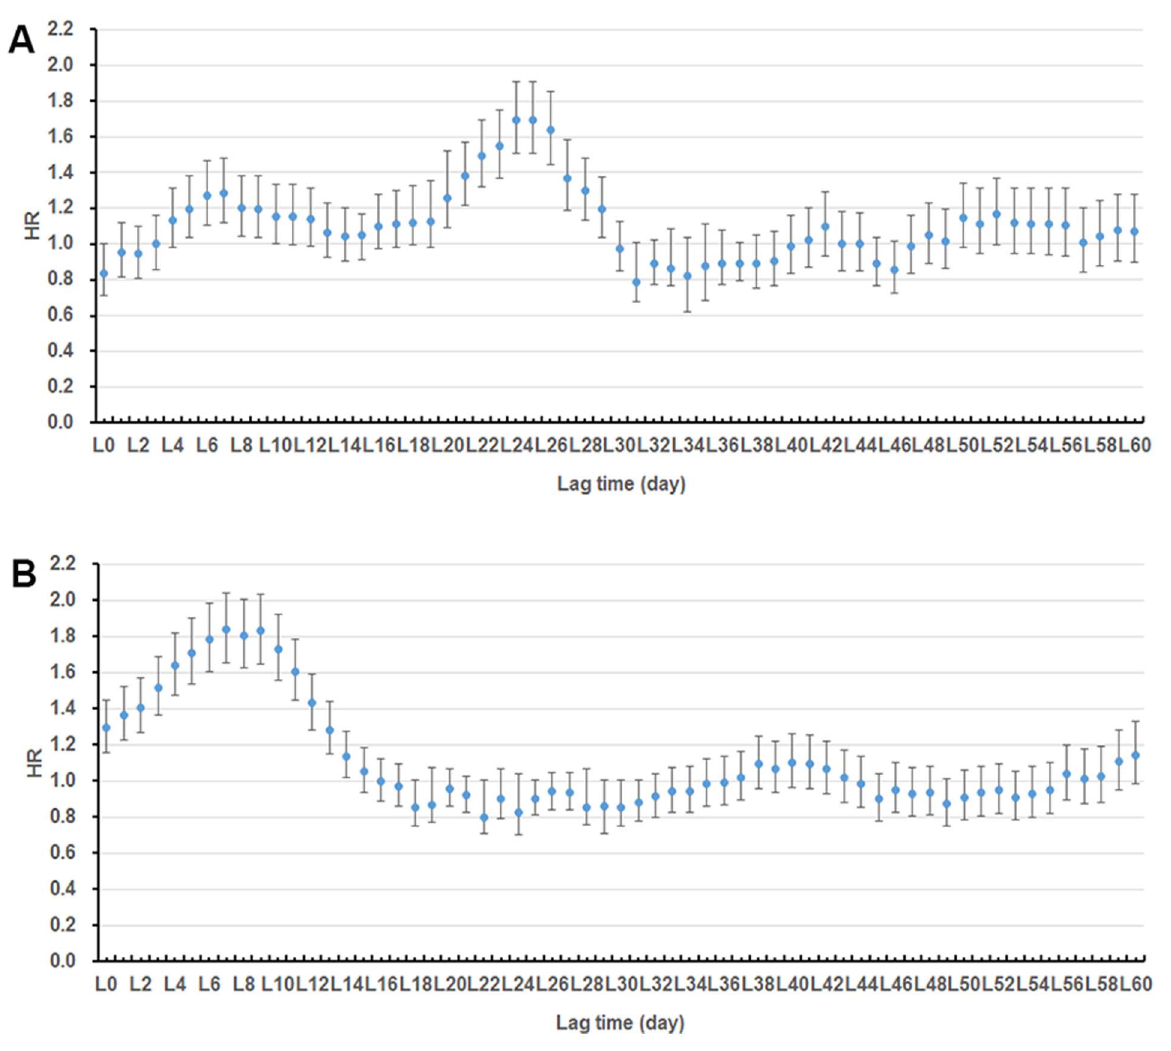
Figure 4. HR estimates of flooding (A) and waterlogging (B) on the risk of malaria in different lagged days.